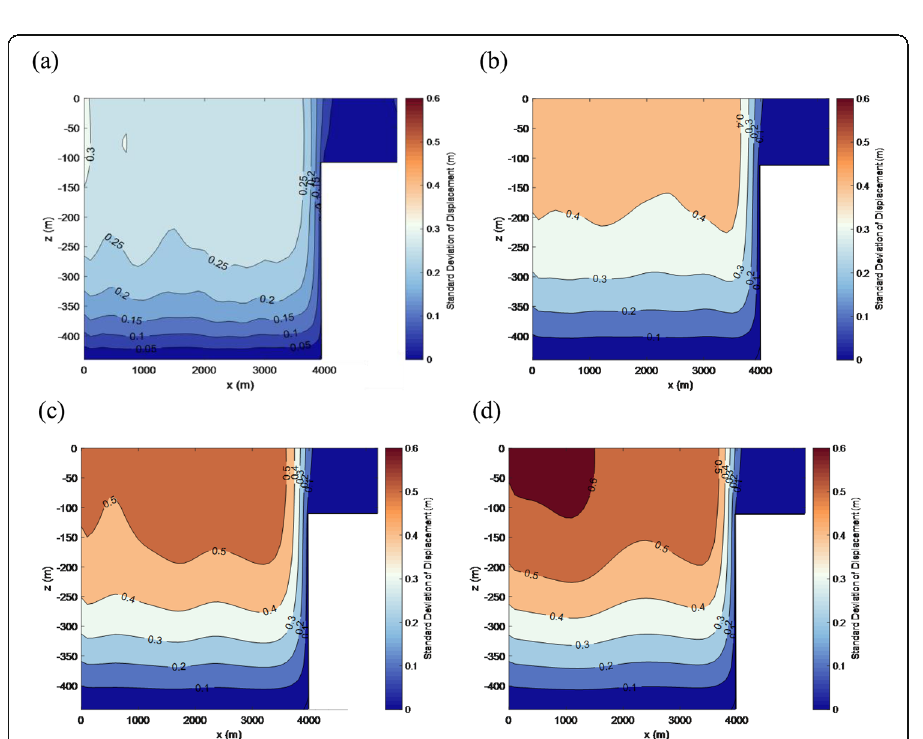
Fig. 6 Effects of the correlation length of E a on the uncertainty of displacement. a l x = 200 m, l z = 40 m. b l x = 400 m, l z = 80 m. c l x = 600 m, l z = 120 m. d l x = 800 m, l z = 160